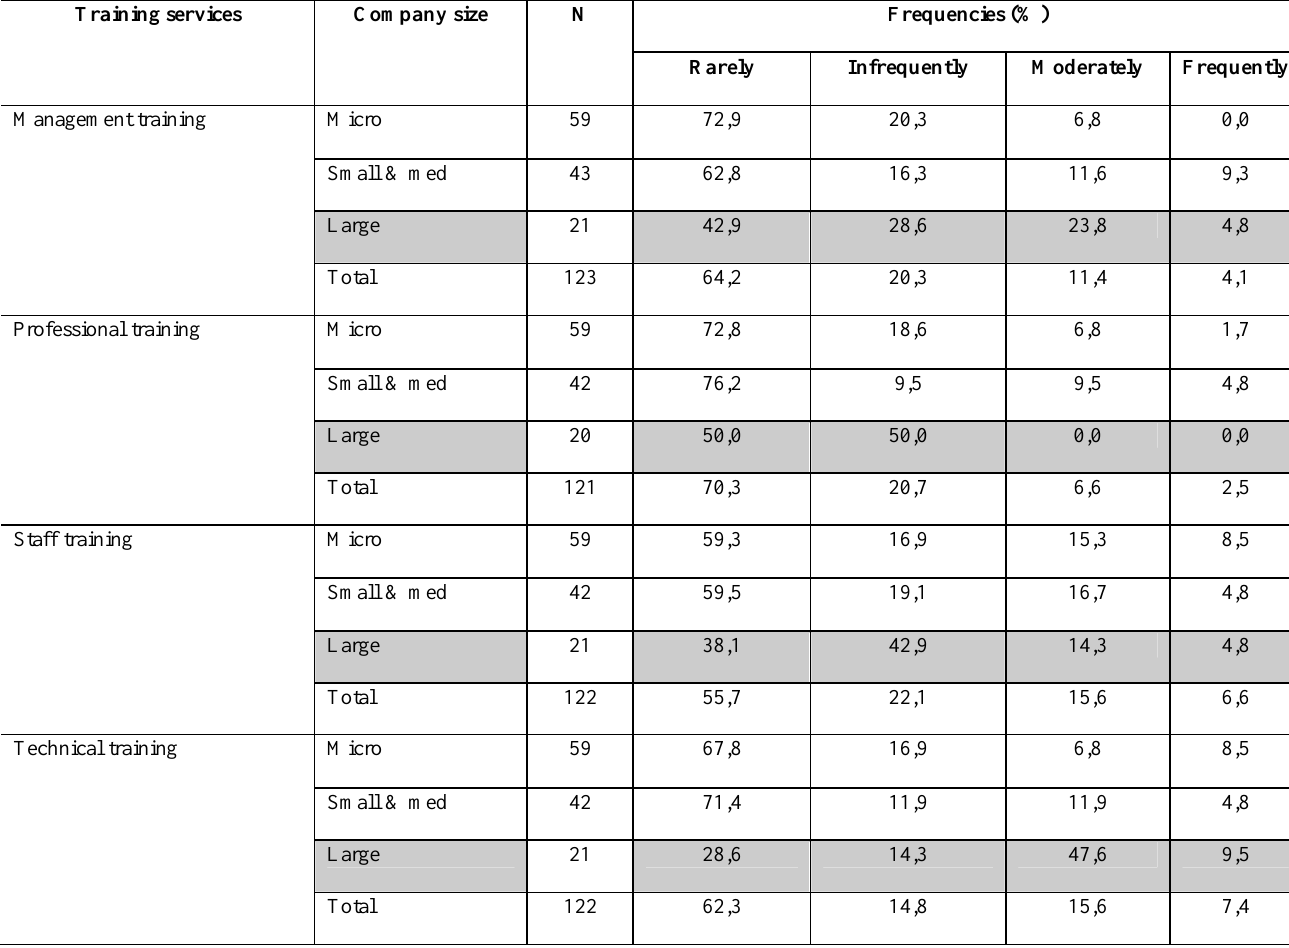
Table 7: Comparison between company size and responses to training